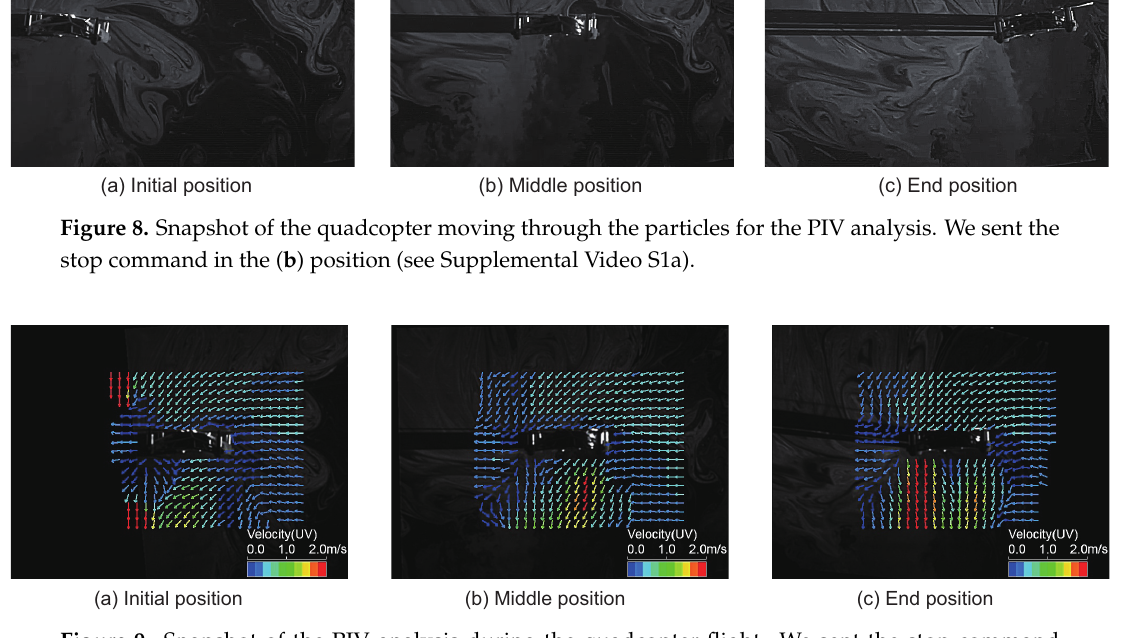
Figure 9. Snapshot of the PIV analysis during the quadcopter flight. We sent the stop command in the ( b ) position. The arrow of the snapshot represents the average velocity vector for 10 ms (see Supplemental Video